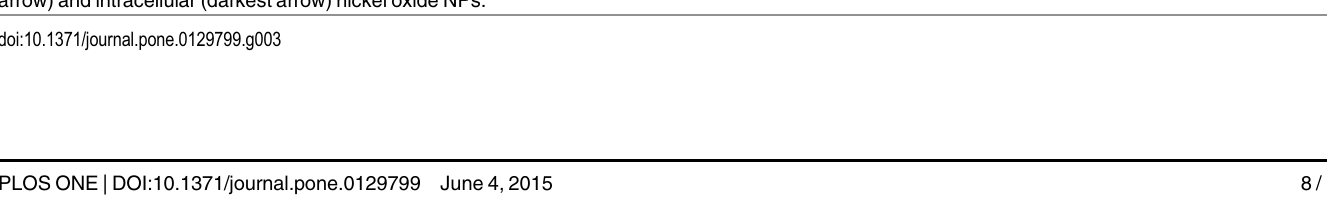
PLOS ONE | DOI:10.1371/journal.pone.0129799 June 4,